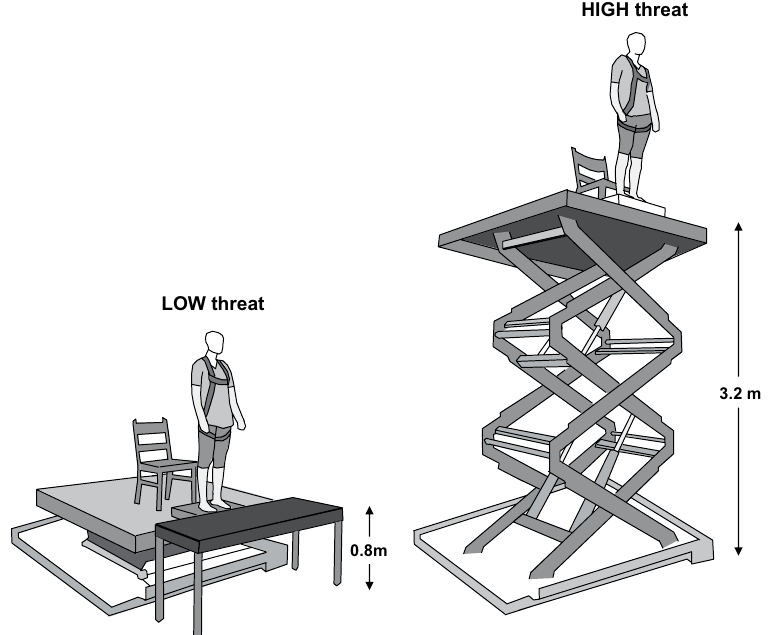
Figure 1. Schematic illustrating the LOW and HIGH postural threat conditions. At the LOW threat condition, participants stood at an elevation of 0.8 m. To minimize anxiety at this condition, an additional support surface (0.6 m × 1.52 m) was positioned in front of, and flush with, the platform edge, creating 60 cm of continuous support surface in front of the participant 16 . At the HIGH threat condition, participants stood at an elevation of 3.2 m and were positioned directly at the edge of the platform. At both threat conditions, participants wore a harness that was secured to the